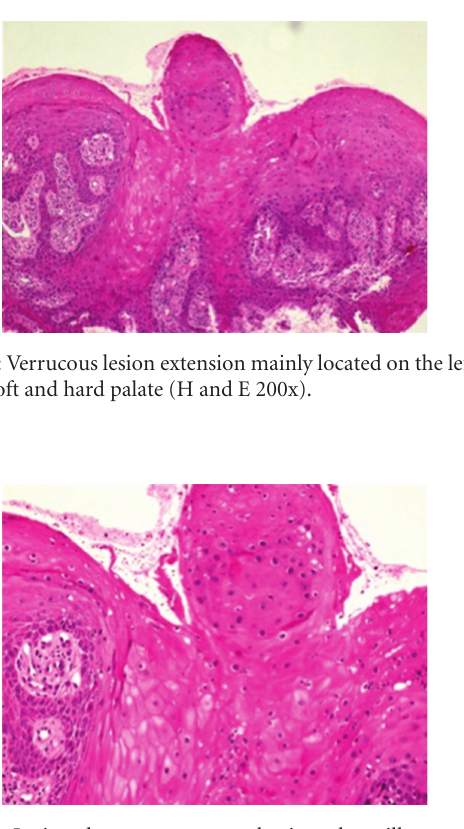
Figure 3: Lesion demonstrates acanthosis and papillomatosis (H and E